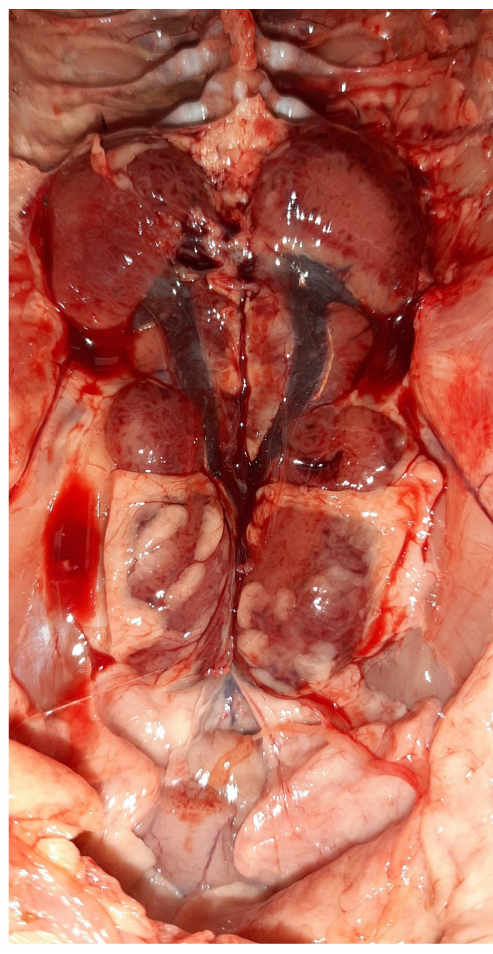
Figure 6. The kidneys of an affected bird are pictured oedematous and mottled, enlarged with urates accumulation in the